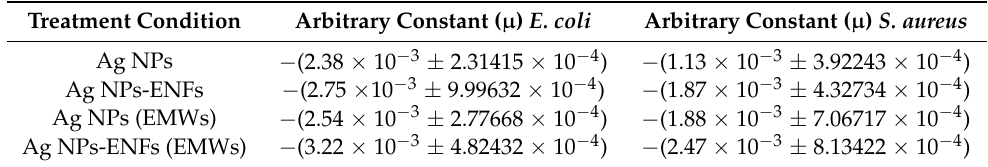
Table 1. List of negative slope trend line values of arbitrary constants for E. coli and S. aureus under each treatment condition at different Ag NPs